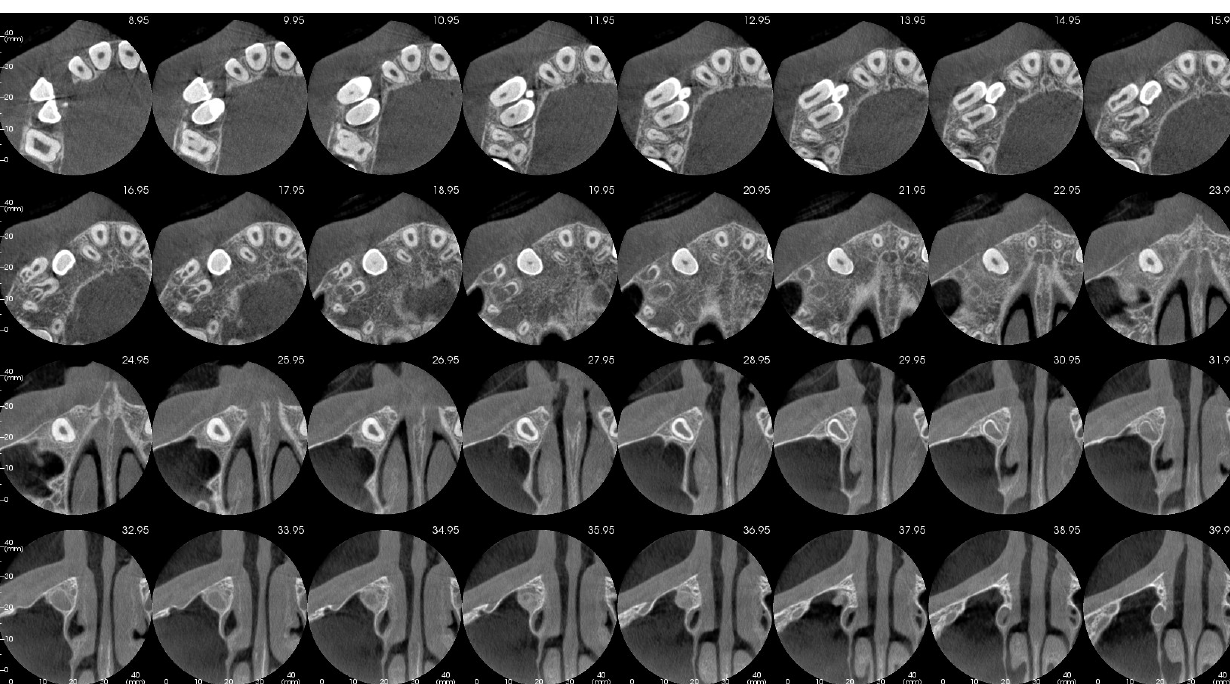
Figure 9. CBCT 6 months after surgery—axial view.